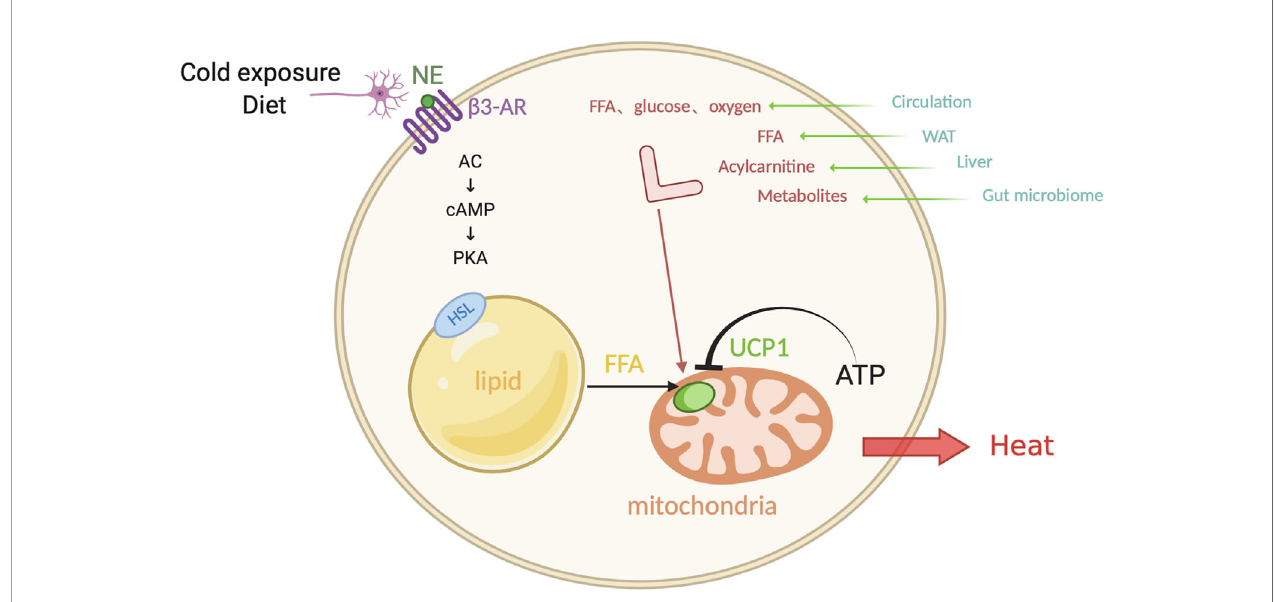
FIGURE 1 | Canonical non-shivering thermogenesis. In response to cold exposure and overeating, norepinephrine (NE) binds to b 3-adrenoceptor ( b 3-AR), initiating adenosine cyclase-cAMP-protein kinase A (AC-cAMP-PKA) pathway. Subsequently the hormone-sensitive lipase (HSL) on the surface of lipid droplets is phosphorylated and the triglycerides translate into free-fatty-acid (FFA) after hydrolysis, which activates uncoupling protein 1 (UCP1) that inhibited by ATP, as a substrate for the following b -oxidation in the mitochondrial matrix. Additionally, interorgan communication provides more available substrates and fuels from exogenous sources, such as glucose, oxygen, FFA, acylcarnitine, metabolites, which come from the circulation, WAT, liver, and gut microbiome. Figure created using BioRender